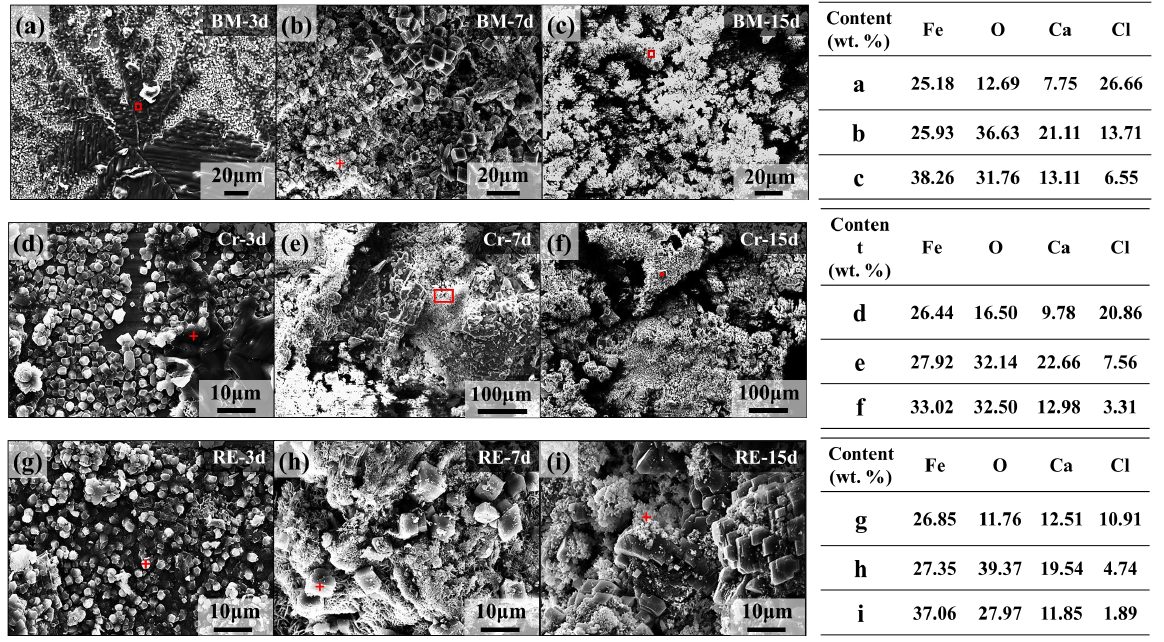
Figure 10. Surface morphologies and element distribution point scanning of the corrosion product film (CPF) of the three steel rebars after the corrosion process in the marine-reinforced concrete pore fluid simulation environment: ( a ) BM-3d, ( b ) BM-7d, ( c ) BM-15d, ( d ) Cr-3d, ( e ) Cr-7d, ( f ) Cr-15d, ( g ) Re-3d, ( h ) Re-7d, and ( i ) RE-15d. (“+” and “square” represent the sites of EDS test).